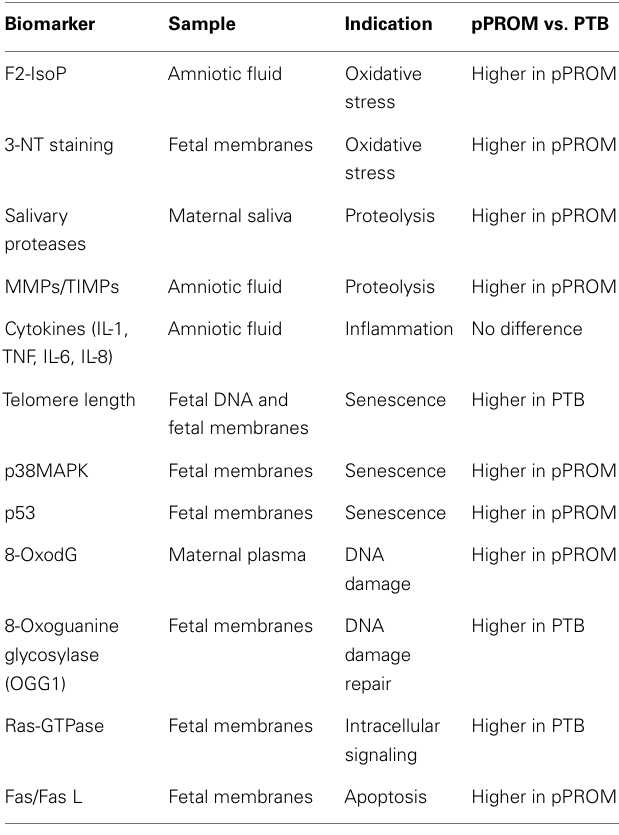
Table 2 | Markers studied in various maternal–fetal compartments and their similarities and differences between PTB with intact membranes and preterm premature rupture of the membranes (pPROM)